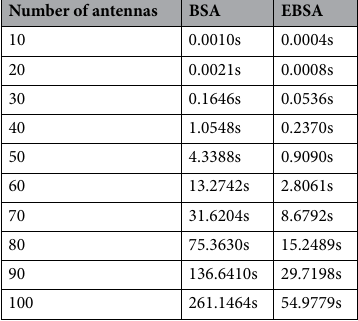
Table 1. Simulation time of covariance matrix reconstruction.